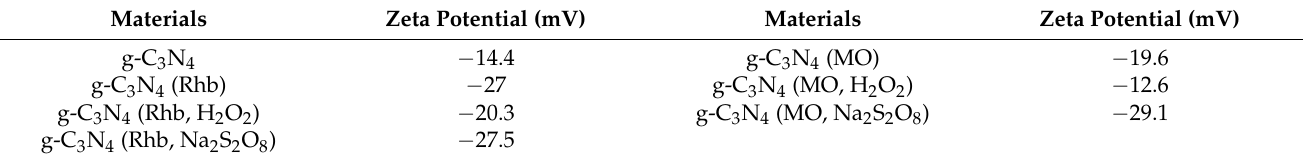
Table 4. Zeta potential of g-C 3 N 4